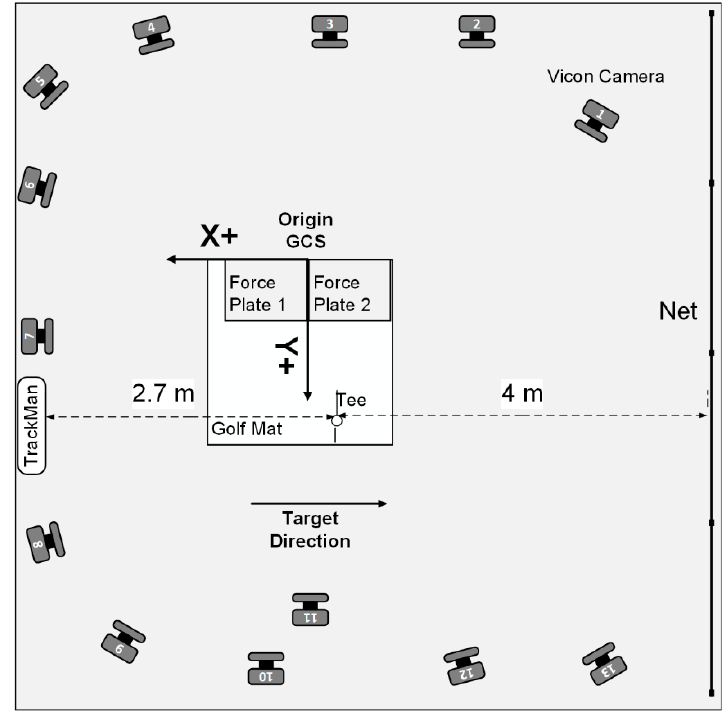
Figure 1. Plan view of laboratory set-up including location of Vicon T-series cameras (1 to 13), TrackMan launch monitor, force plates and net. The location of the global co-ordinate system (GCS) origin and target direction are also shown.